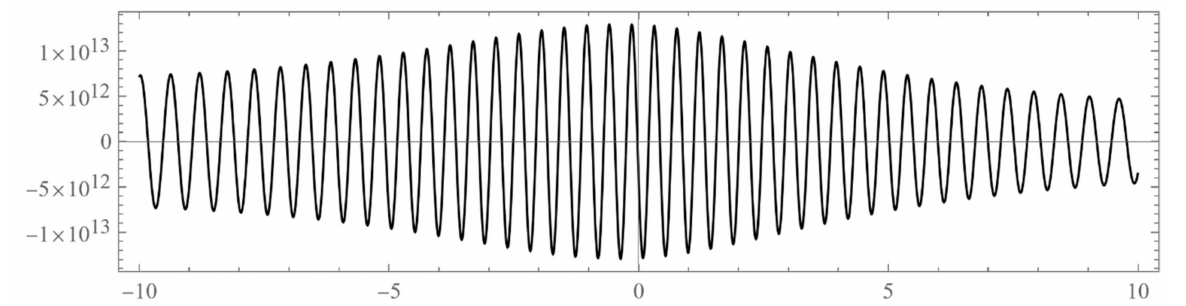
Figure A11. The un-normalized wavefunction (cid:101) ψ ( x , E ) for E = λ 2 /4, which is a forbidden energy in the gap. We took N = 100. Note the unbounded oscillations everywhere.